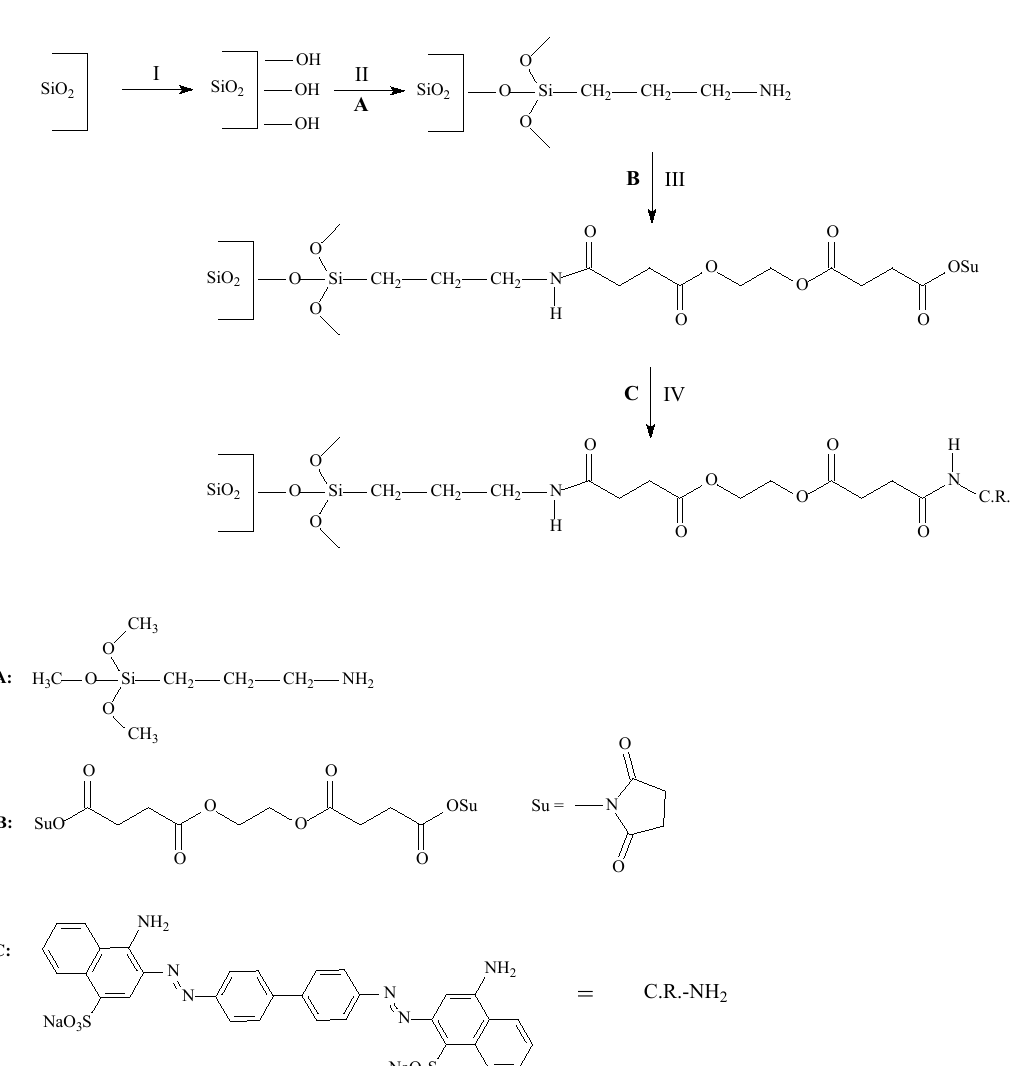
Scheme 1. Synthesis of the support